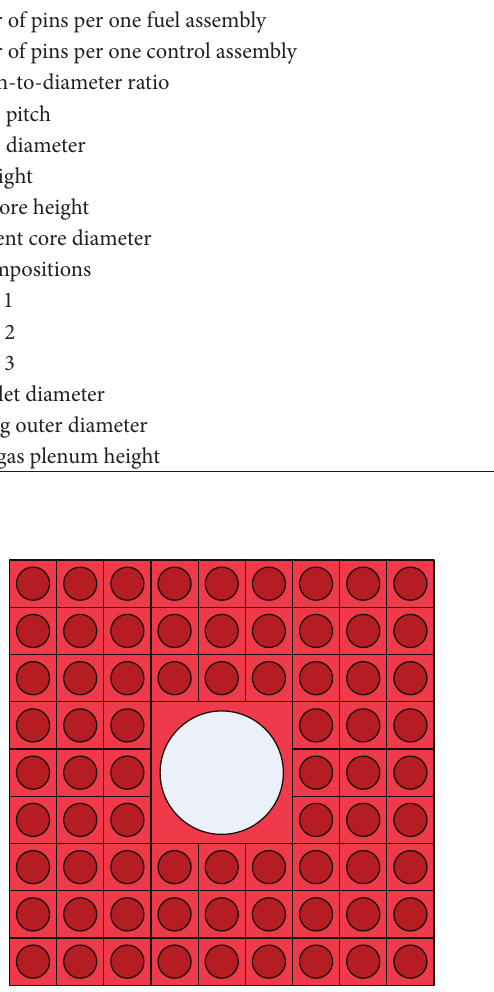
Figure 4: Scheme of control rod assembly.